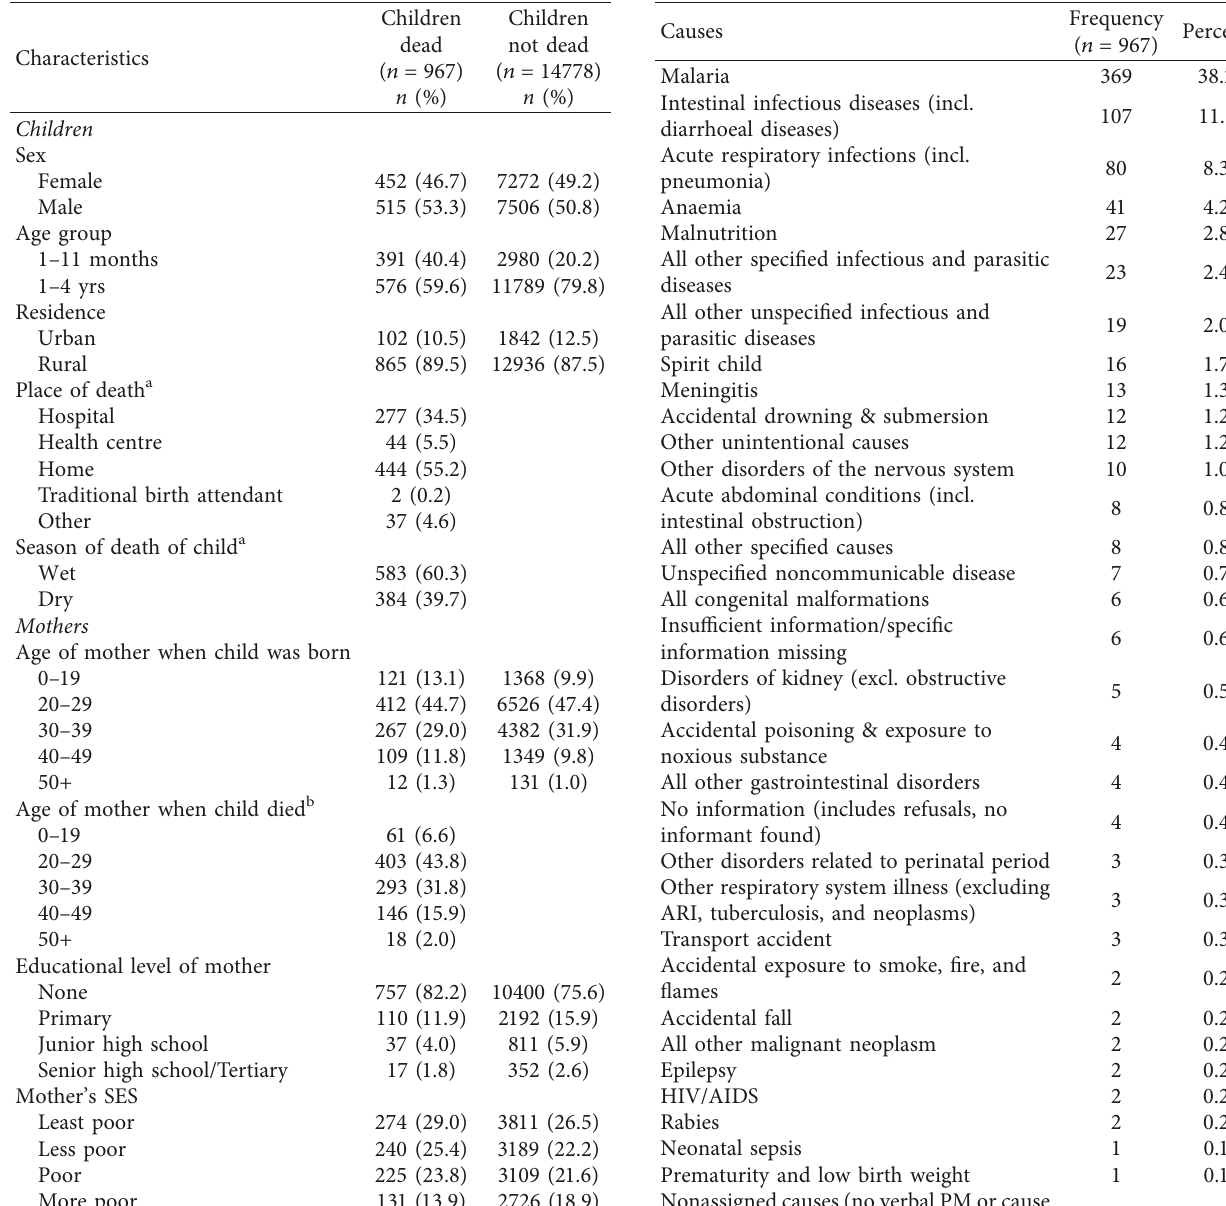
Table 2: Causes of child mortality in the Kassena-Nankana